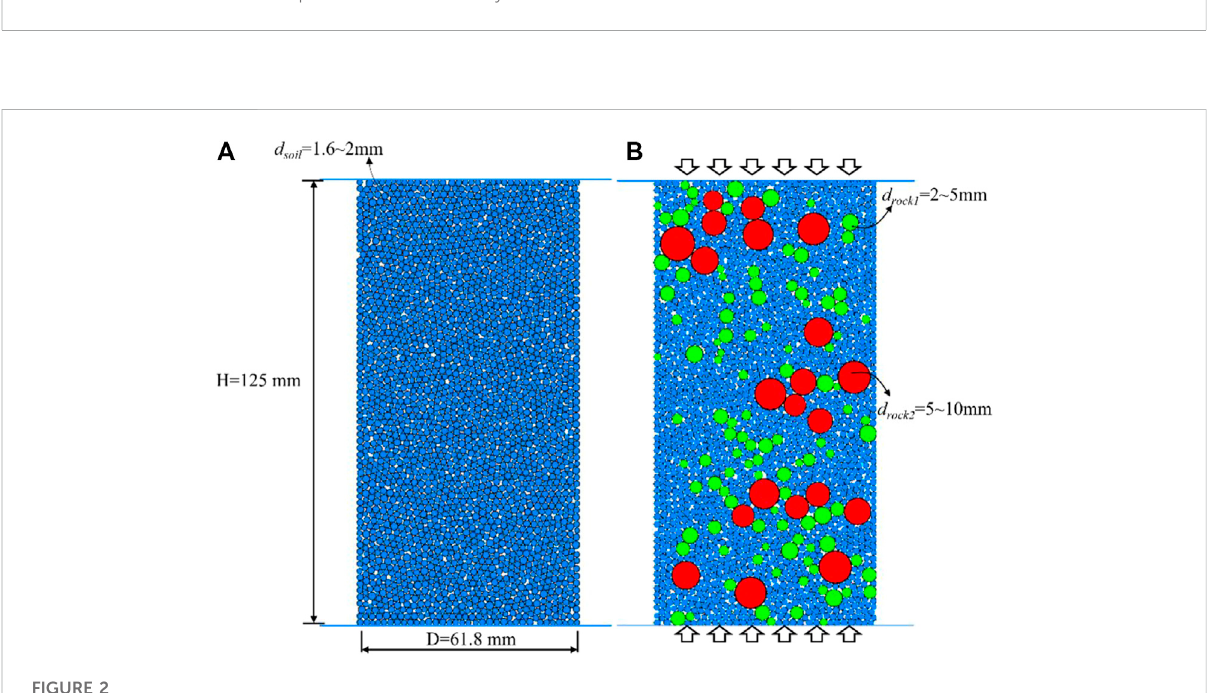
FIGURE 2 S-RM particle models for the